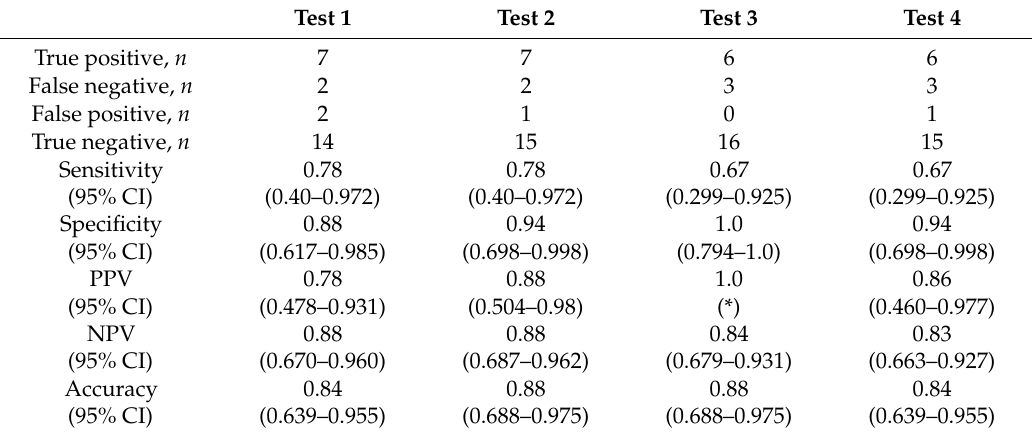
Table 5. Contingency table of four helpful testing tools for diagnosis of IgG4-related orbital disease (IgG4-ROD). Test